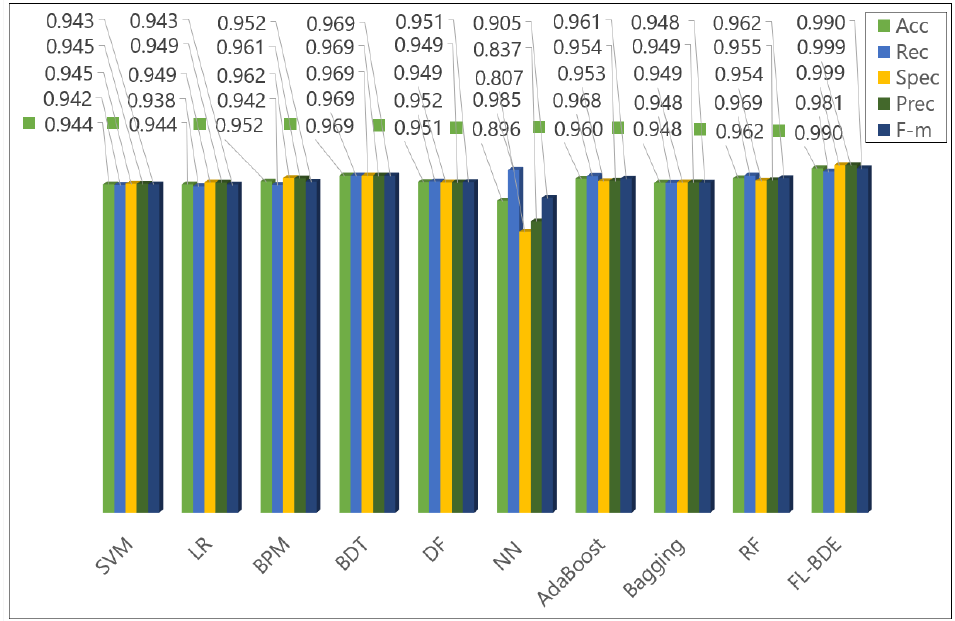
Figure 9. Performance results of FL-BDE, ML- and EL-based models for 5-fold cross-validation.